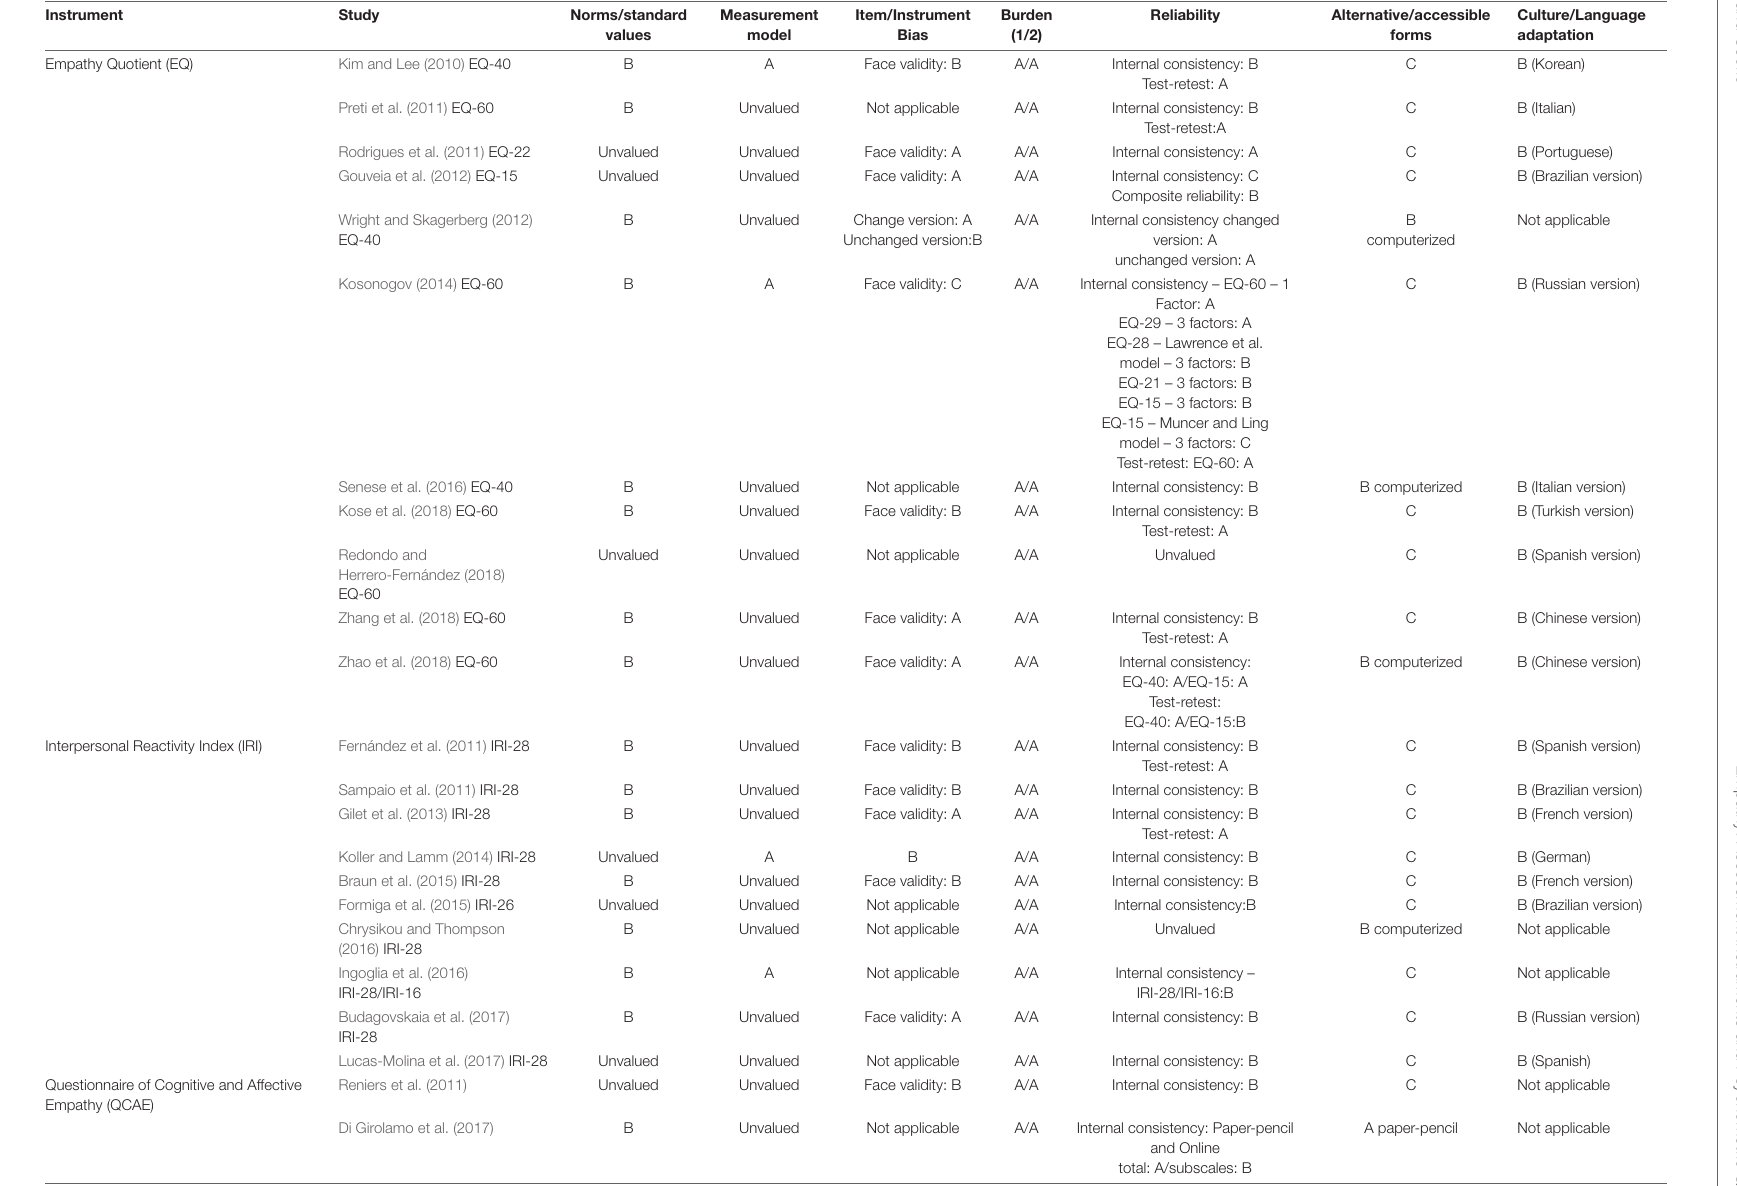
TABLE 3 | Analysis of psychometric qualities by the different instruments, according to the studies analyzed ( n = 50) – Part A. Instrument